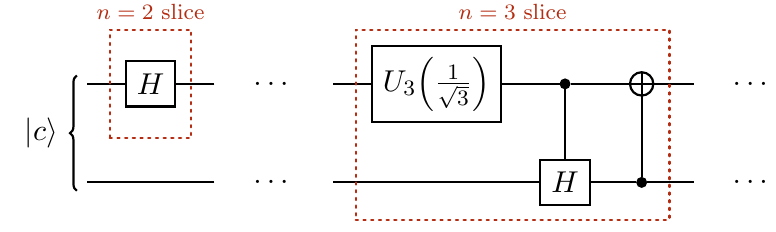
Figure 8. Coin operations for slices with n = 2 and n = 3